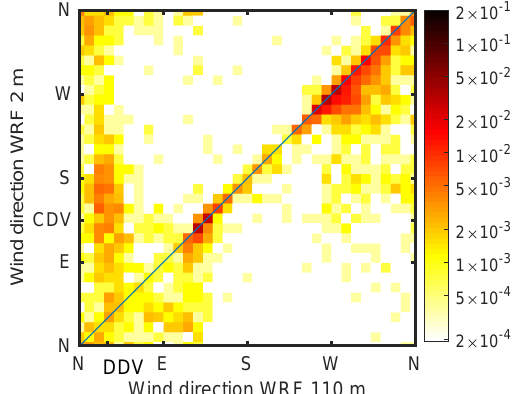
Figure 3. Probability density showing the comparison between 2 m and 110 m observed wind direction. After Dupuy et al. [22].